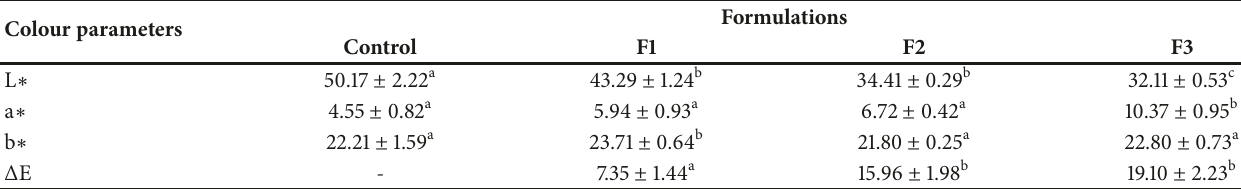
Table 3: Instrumental colour parameters in the different formulations of snacks ∗